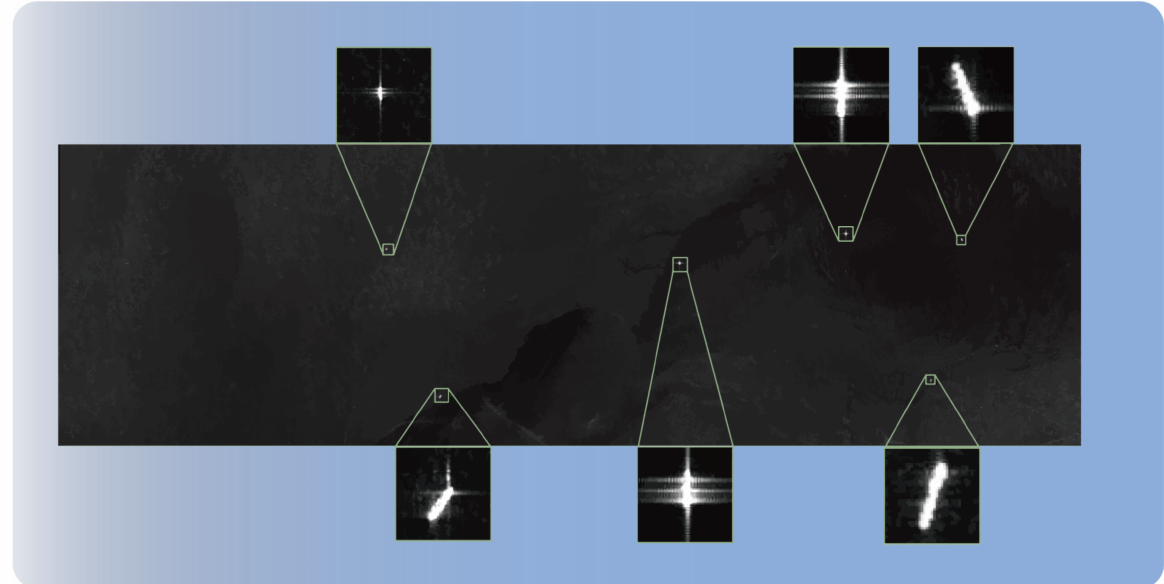
Figure 4. Typical scene for maritime